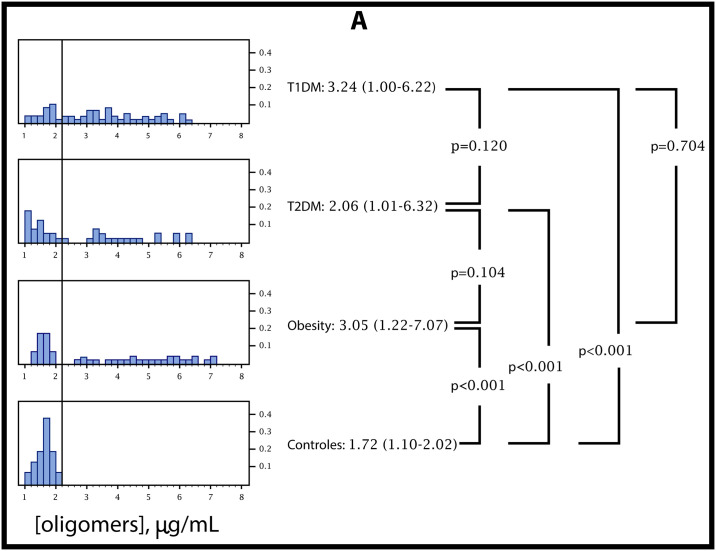
RIAO distribution of the four groups for visual comparison and the results of statistical analysis among groups by Welch’s test.Pairwise tests were done in a protected manner (one-way ANOVA with Welch’s correction: p<0.001).